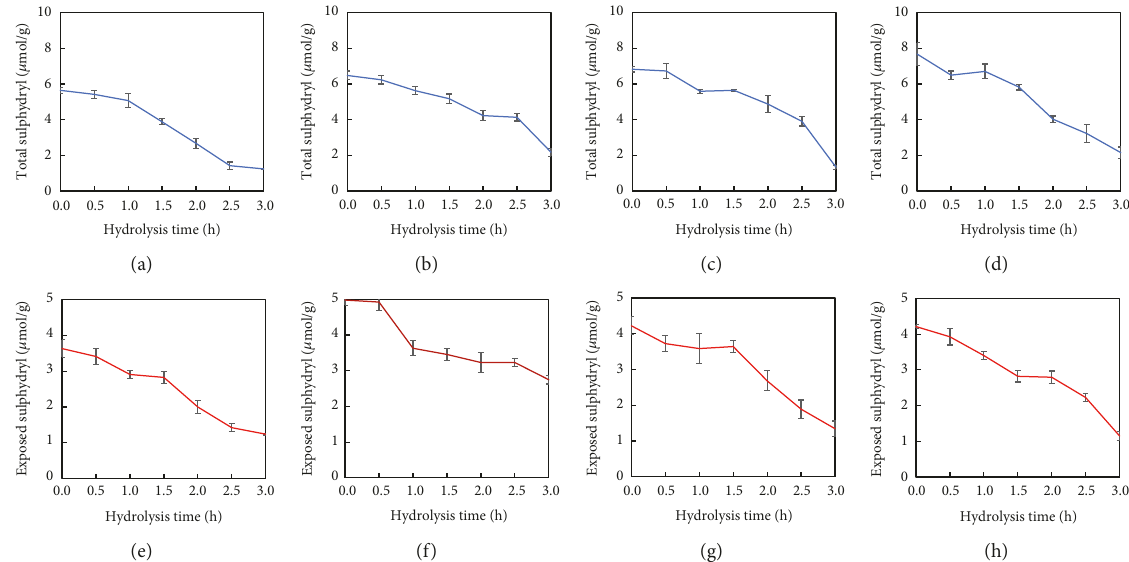
Figure 4: Total sulphydryl of (a) nonextruded, (b) Ex60-HSPP, (c) Ex80-HSPP, and (d) Ex100-HSPP. Exposed sulphydryl of (e) nonextruded, (f) Ex60-HSPP, (g) Ex80-HSPP, and (h) Ex100-HSPP.